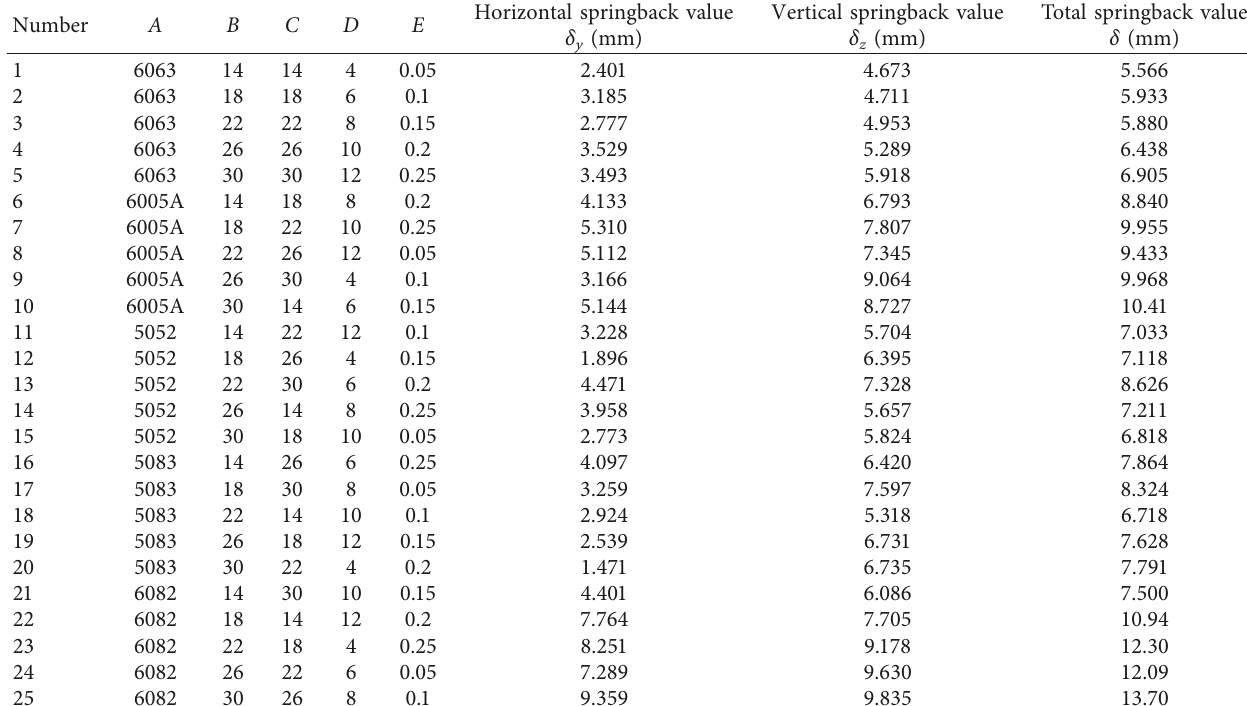
Table 4: Design and results of the orthogonal experiment.